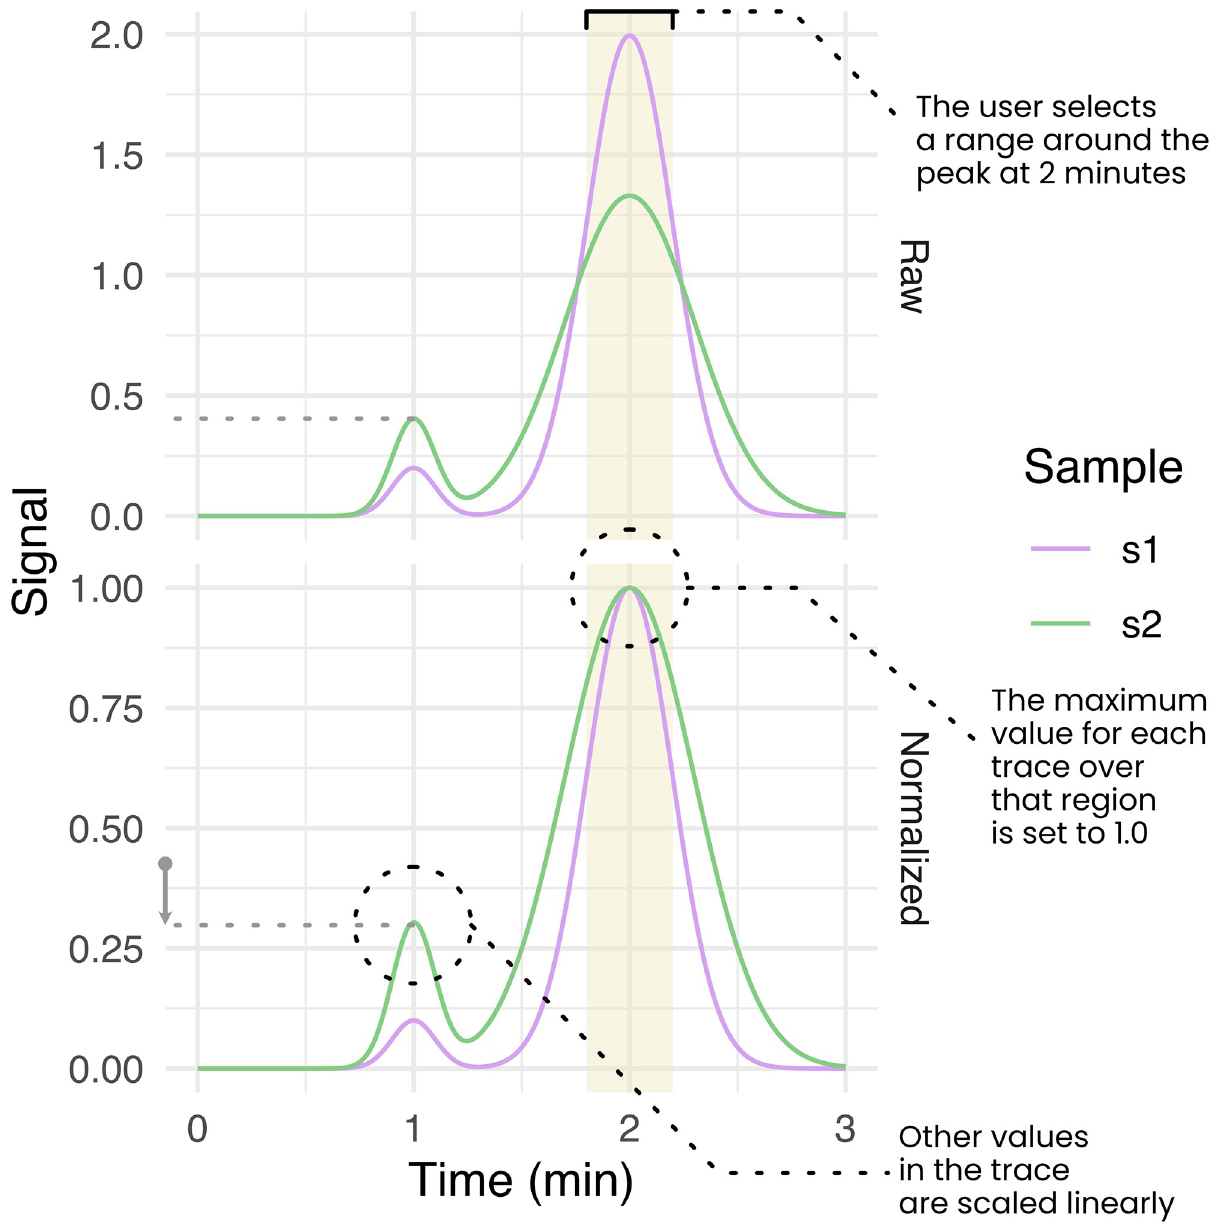
Fig 3. The Appia normalization process. Users first select a range over which to normalize, either by zooming into it in the web interface or entering it in the command line during processing. For each trace, the maximum value over that range is set to 1.0, and all other values along the trace are scaled linearly. Optionally, during processing (but not the web interface), the minimum value can be set to 0 as